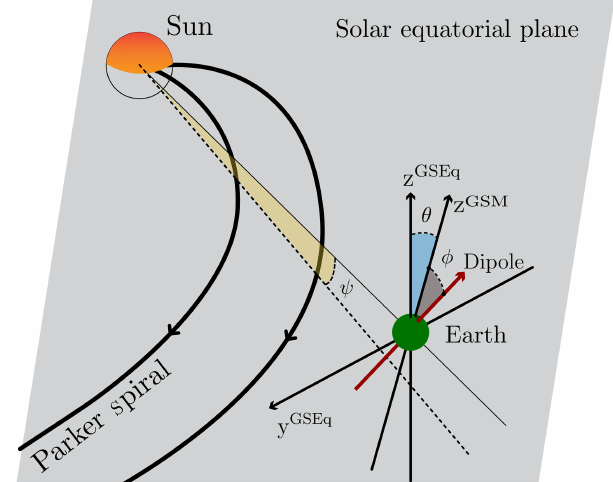
Figure 7. φ , θ and ψ in the Sun–Earth environment (see text for de- tails). Parker spirals lie approximately in the solar equatorial plane that is shown in gray. GSEq and GSM are the geocentric solar equa- torial and geocentric solar magnetospheric coordinate systems, re-